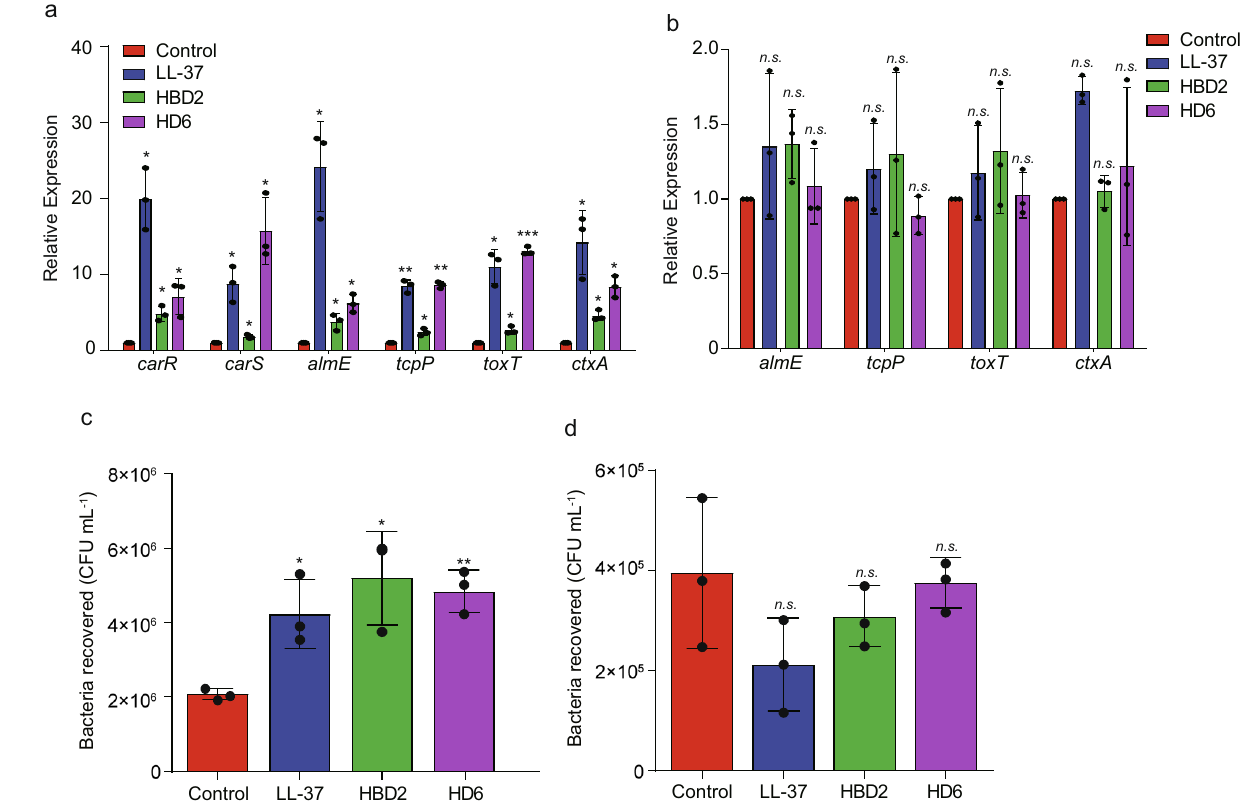
Fig. 6 CAMPs promote V. cholerae adhesion and virulence gene expression through similar molecular mechanisms. a , b qRT-PCR analysis of the expression of corresponding genes in WT ( a ) and Δ carR ( b ) in AKI medium containing 50 μ g/mL LL-37, HBD2, and HD-6. Data are presented as the mean ± SD ( n = 3). c , d Adherence of WT ( c ) and Δ carR ( d ) to Caco-2 cells containing 50 μ g/mL LL-37, HBD2 and HD-6. Data are presented as mean ± SD ( n = 3). Signi fi cance was determined by two-tailed unpaired Student ’ s t test ( a – d ). * P ≤ 0.05; ** P ≤ 0.01; *** P ≤ 0.001; n.s. no signi fi cant